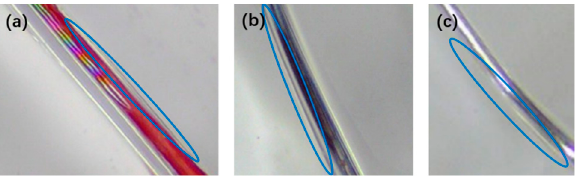
Figure 5. The sealing conditions of Pyrex glass and the different kinds of metal wires. The gap between Pyrex glass and the metal is marked by blue ellipses. ( a ) Dumet wire. ( b ) Kovar alloy. ( c ) Platinum wire.